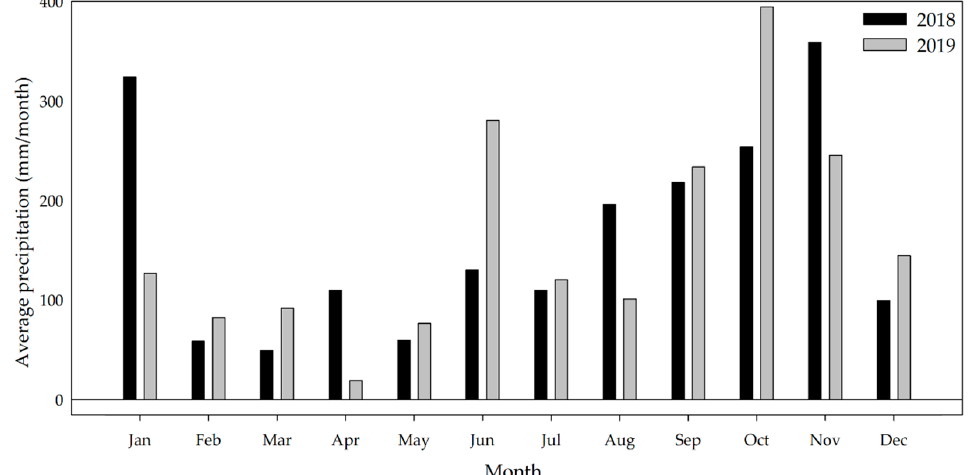
Figure 2. Monthly average precipitation (data available at